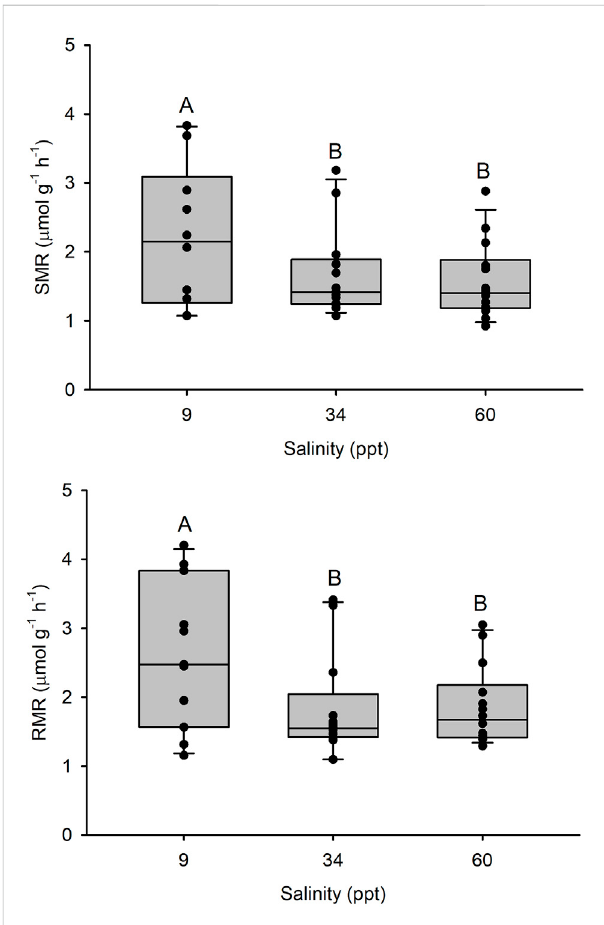
FIGURE 1 Top panel: Standard metabolic rate (SMR) and bottom panel: Resting metabolic rate (RMR) in Gulf toad fi sh ( Opsanus beta ) acclimatedto 9, 34 or 60 ppt. Median, range,upper and lower quartile as well as individual observations (n = 10, 13, 14, respectively). Groups labelled with different letters are statistically signi fi cant different ( p <